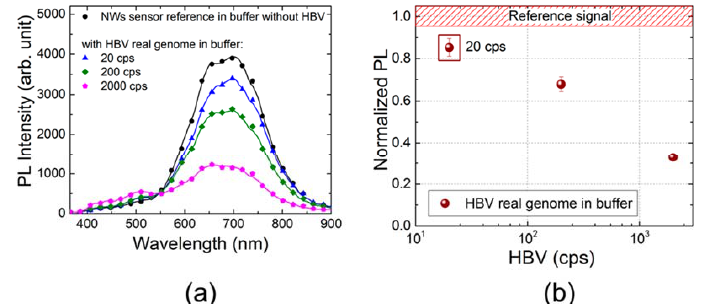
Figure 10. ( a ) Photoluminescence (PL) spectra of the NWs sensor tested in hepatitis b virus (HBV) real genome extracted from infected human blood and spiked in buffer reported for different con- centrations ranging from 20 cps up to 2000 cps. The PL reference of the sensor without any copies of HBV is shown in black. ( b ) The trend of the PL integrated peak of the deconvolved NWs PL emission as a function of real HBV genome concentration normalized to its reference signal (red bar) obtained by the buffer solution without any real HBV copy. Reprinted with permission from ref. [77]. 2018 American Chemistry Society